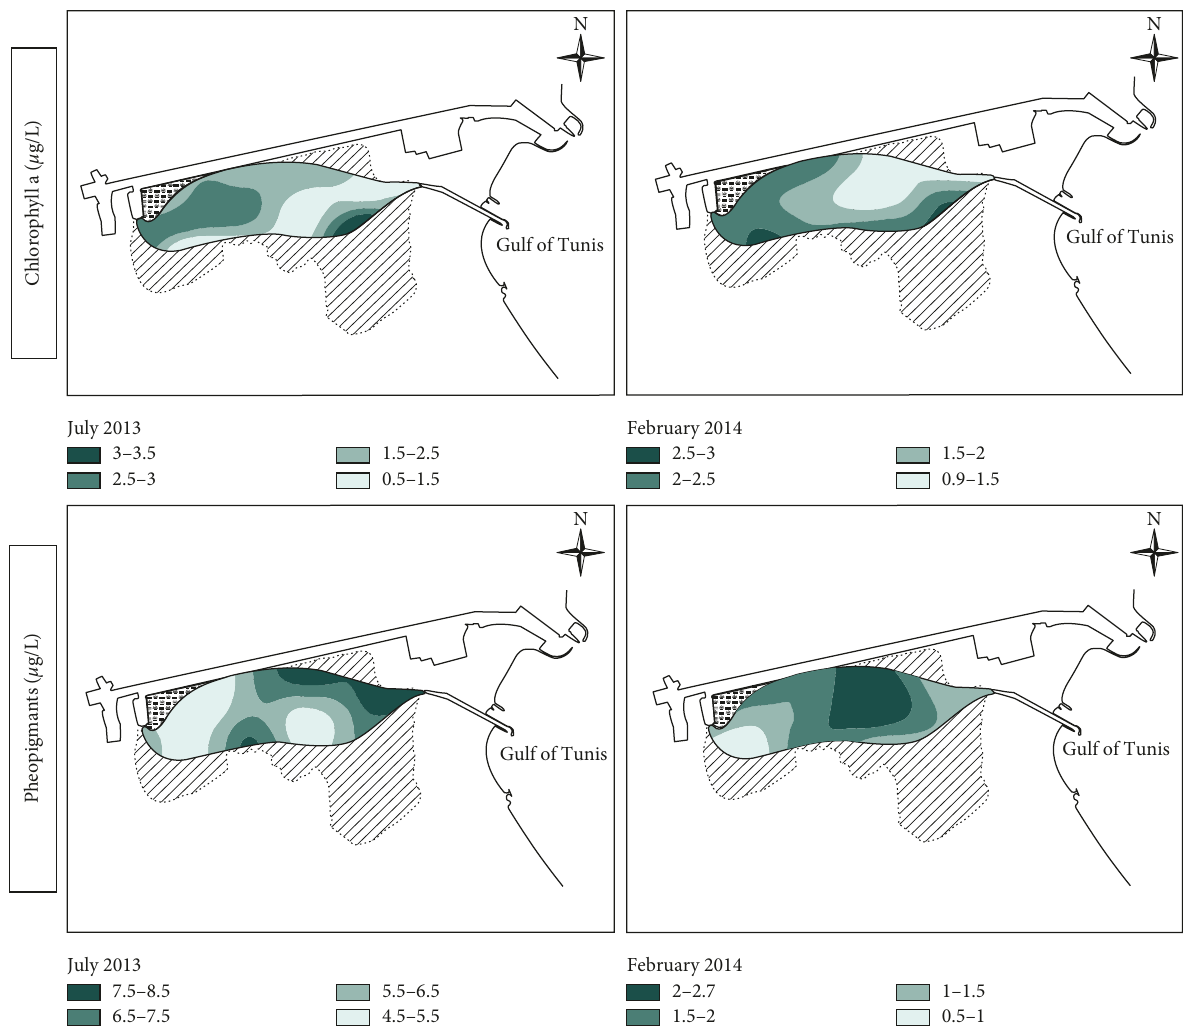
Figure 10: Spatial distribution maps of chlorophyll a ( µ g/L) and pheopigmants ( µ g/L) in surface water of the South Lagoon of